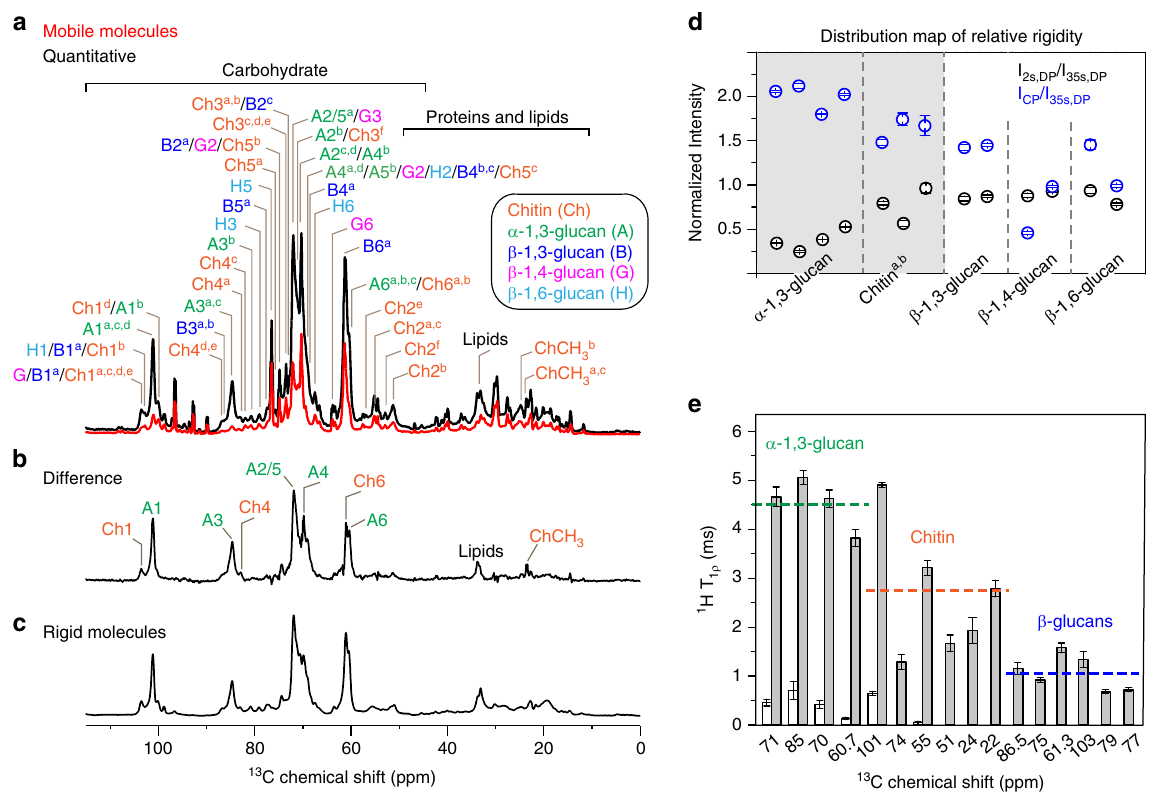
Fig. 5 A. fumigatus cell walls are dynamically heterogeneous. a 1D 13 C DP spectra of intact A. fumigatus cells with quantitative detection of all molecules (black) or selective detection of the mobile components (red). Abbreviations of carbohydrate names, carbon numbers, and subtypes (superscripts) are included in the assignment. b Difference spectrum obtained by subtraction of the two 1D DP spectra. c 13 C CP spectrum that favors rigid molecules. d Peak intensity ratios between different DP spectra and the CP spectrum show that α -1,3-glucan and a subset of chitins are relatively rigid. Error bars are standard deviations propagated from NMR signal-to-noise ratios. e 1 H-T 1 ρ relaxation times. The open and fi lled bars represent the short and long-components of 1 H- T 1 ρ relaxation. Error bars are standard deviations of the fi t parameters. Dashlines indicate the average value of the longer 1 H-T 1 ρ component for each type of